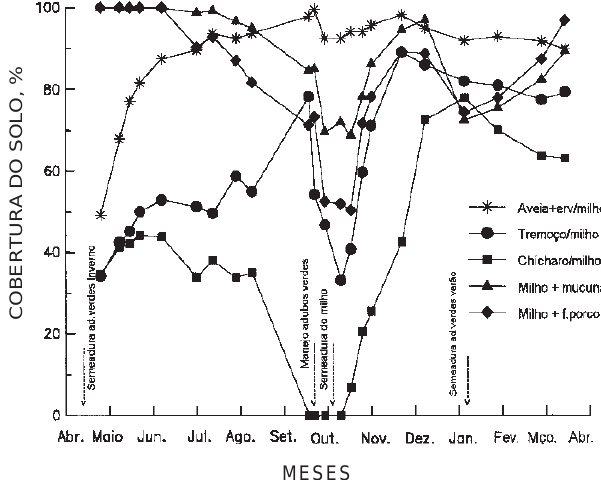
Figura 1. Cobertura do solo, nos sistemas de produção de milho, de abril/92 a março/93.